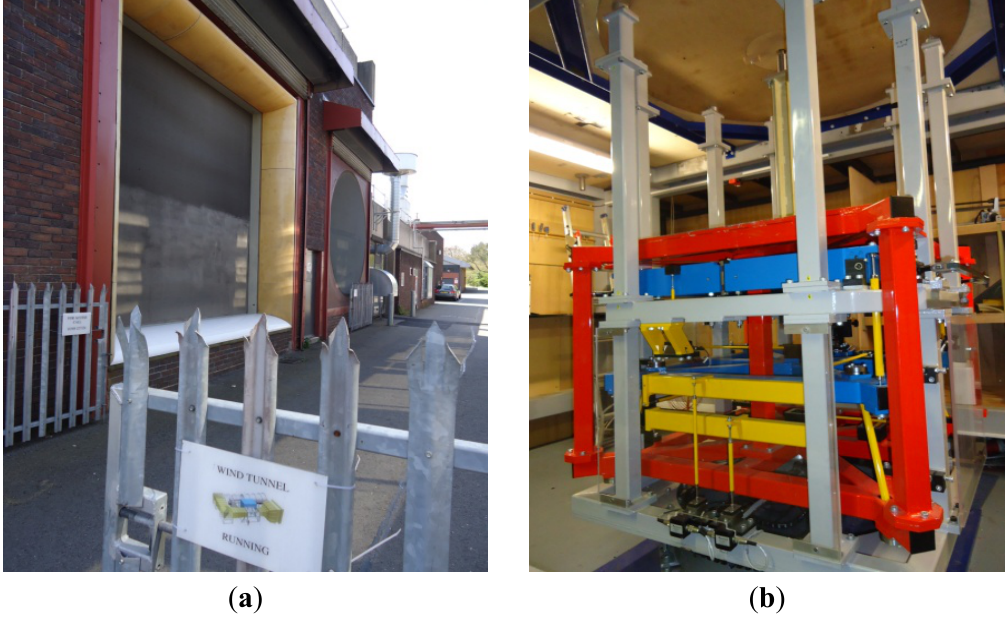
Figure 4. ( a ) LU AAE Wind Tunnel Bell-mouth and Exhaust; ( b ) Balance below Tunnel Working